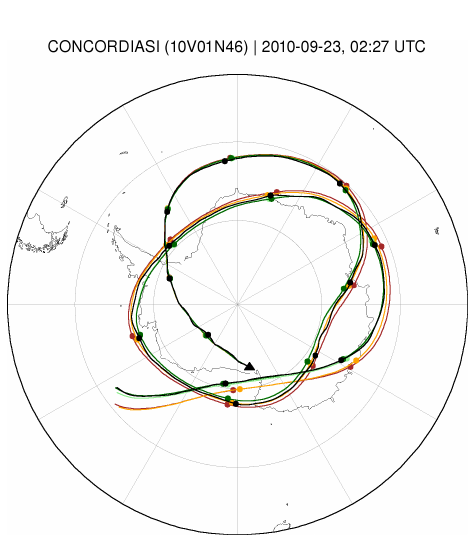
Figure 6. Comparison of 15-day trajectories calculated with dif- ferent types of vertical motion (dark green: balloon pressure; light green: isopycnic; orange: isentropic; red: omega velocity) and cor- responding Concordiasi balloon trajectory (black). The plot title provides the gondola ID and the starting time. The triangle indicates the starting position of the trajectories. Circles indicate trajectory positions at 00:00UTC each